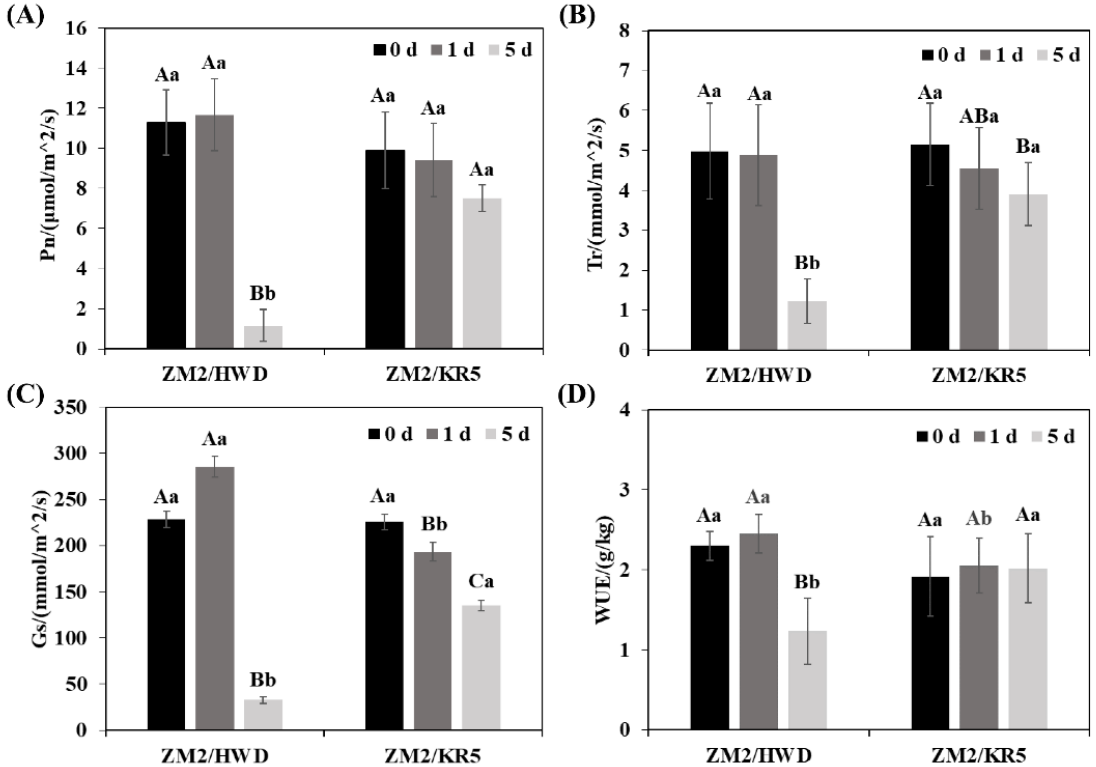
Figure 2. ( A ) Net photosynthesis (Pn), ( B ) transpiration rate (Tr), ( C ) stomatal conductance (Gs), and ( D ) water use efficiency (WUE) of ZM2/HWD and ZM2/KR5 kiwifruit plants under waterlogging stress. ZM2/HWD and ZM2/KR5 indicate grafting ‘ Zhongmi 2 ′ onto ‘ Hayward ’ and KR5 rootstocks, respectively. Data are the mean values ± SD ( n = 3). Capital letters denote significant differences between the different waterlogging treatment stages for each scion–rootstock combination, and lower-case letters denote significant differences among the scion–rootstock combinations within the different waterlogging treatment stages according to a least significant difference (LSD) test ( p ≤ 0.05).